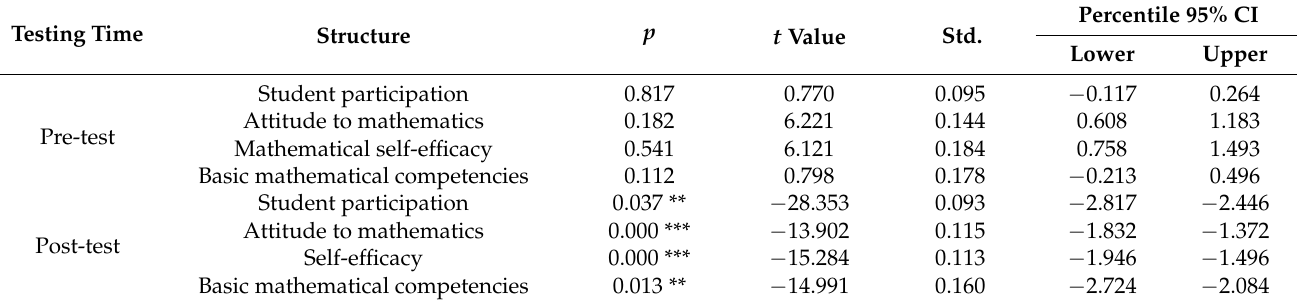
Table 9. Independent samples t -test for experimental and control classes.